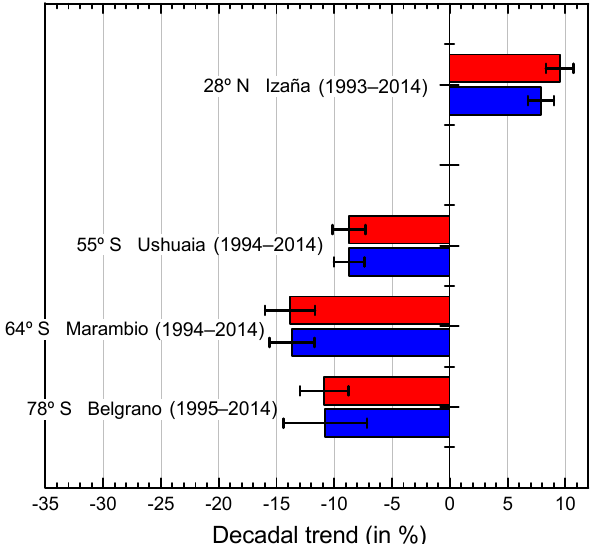
Figure 6. AM (red) and PM (blue) decadal trends obtained for the DOAS stations. The trend at Belgrano was obtained for the February–March–April period. See the text for details.